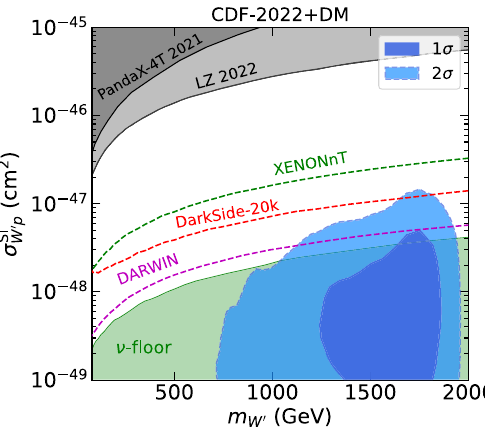
Fig. 10 The 1 σ (dark blue) and 2 σ (light blue) favored regions of the data from CDF-2022+DM projected on the plane of the DM mass and spin independent DM-proton scattering cross section for the heavy DM mass scenario. The dark and light gray regions are the exclusion from PandaX 4T [81] and LZ [82] experiments. The dashed green, red and purple lines represent future sensitivities from the DM direct detections atXENONnT[88],DarkSide-20k[89]andDARWIN[90],respectively. Green region is the neutrino floor background